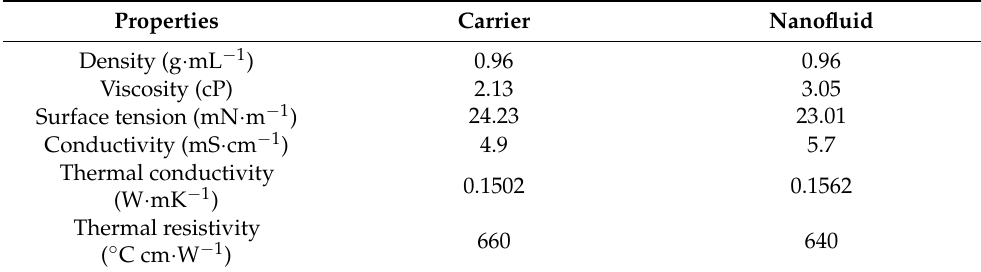
Table 5. Basic characteristics of carrier and